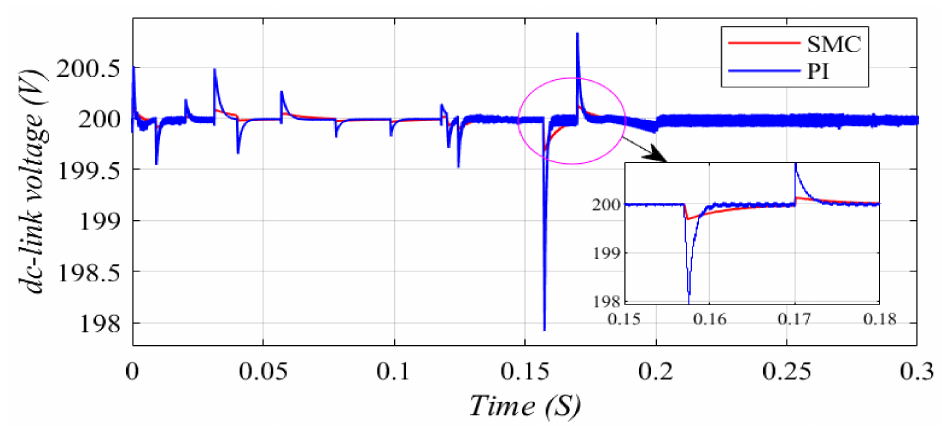
Figure 10. The DC-link voltage output under load and radiation changes.